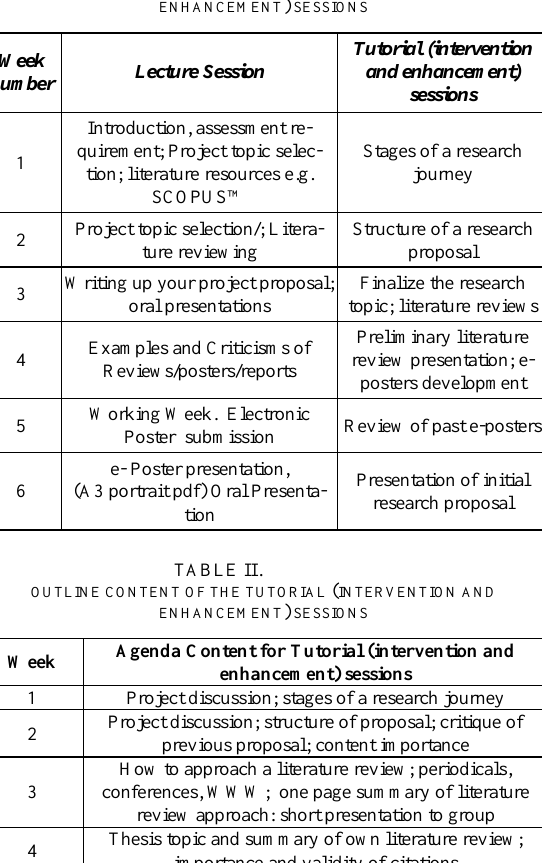
TABLE I. F RAMEWORK OF THE L ECTURE AND T UTORIAL ( INTERVENTION AND ENHANCEMENT ) SESSIONS